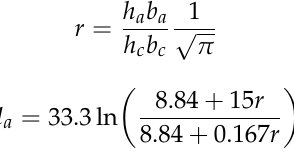
Figure 6. The Raman spectrum for the as-swan silicon wafer. According to the study of Reference [7], the depth of the amorphous silicon layer can be obtained by the ratio r, which is the ratio of the amorphous surface area and the un-phase transitions surface area. The other method for getting the ratio r is by calculating the surface of under the Raman spectrum curve of a different peak value. After obtaining r , Equations (1) and (2) are used to get the amorphous layer depth. The Raman spectrum should be fitted first. The peak height h a (a.u) and bandwidth b a ( cm − 1 ) for amorphous silicon, and the peak height h c (a.u) and bandwidth b c ( cm − 1 ) for single crystal silicon can be obtained by the above curve fitting method.